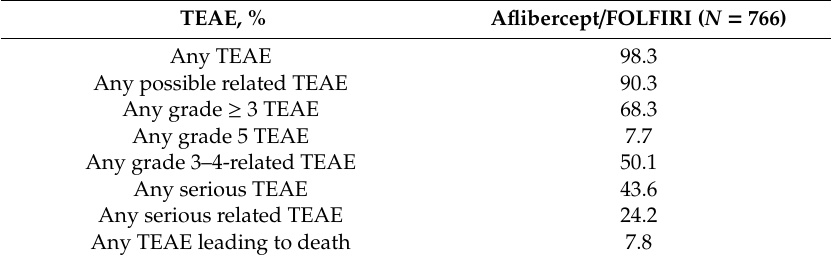
Table 3. OZONE overview of treatment-emergent adverse events.